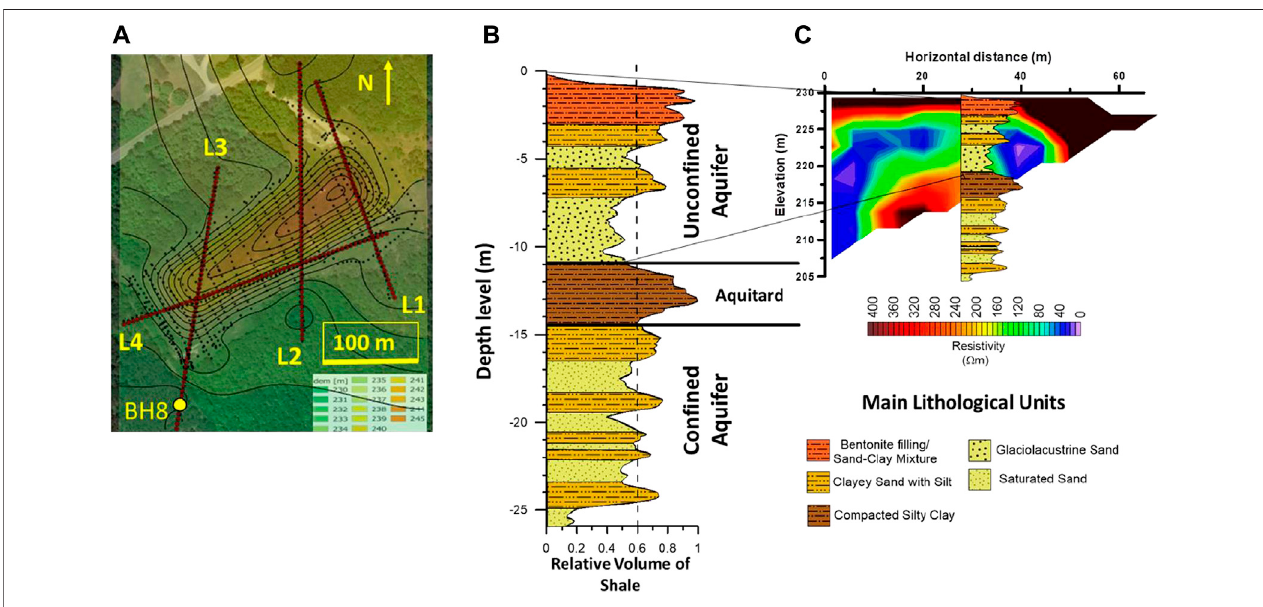
FIGURE1|(A) Mapoftheland fi llsiteinsouthernOntarioshowingthefourgeoelectricalsurveyedlines,topographicdata(blackdots),andlocationofboreholeBH8 that lies on the lower end of the western most L3. (B) Hydrostratigraphic interpretation of the Gamma Ray (GR) log for borehole BH8 using volumes of shale. (C) Correlation between GR information and the inverted electrical resistivity tomography image for the westernmost geoelectrical surveyed L3 (after Jacome et al., 2021).